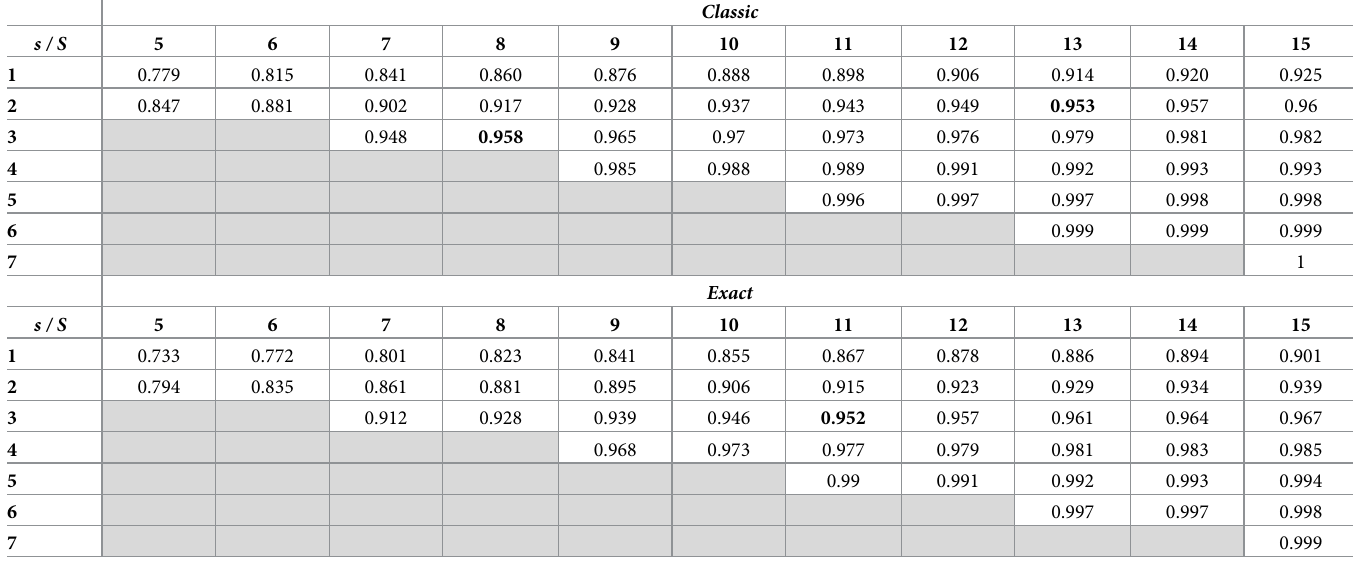
Table 4. Base-stock level and ROP computed by β Classic and β Exact with Poisson demand with λ = 1 and L = 2.